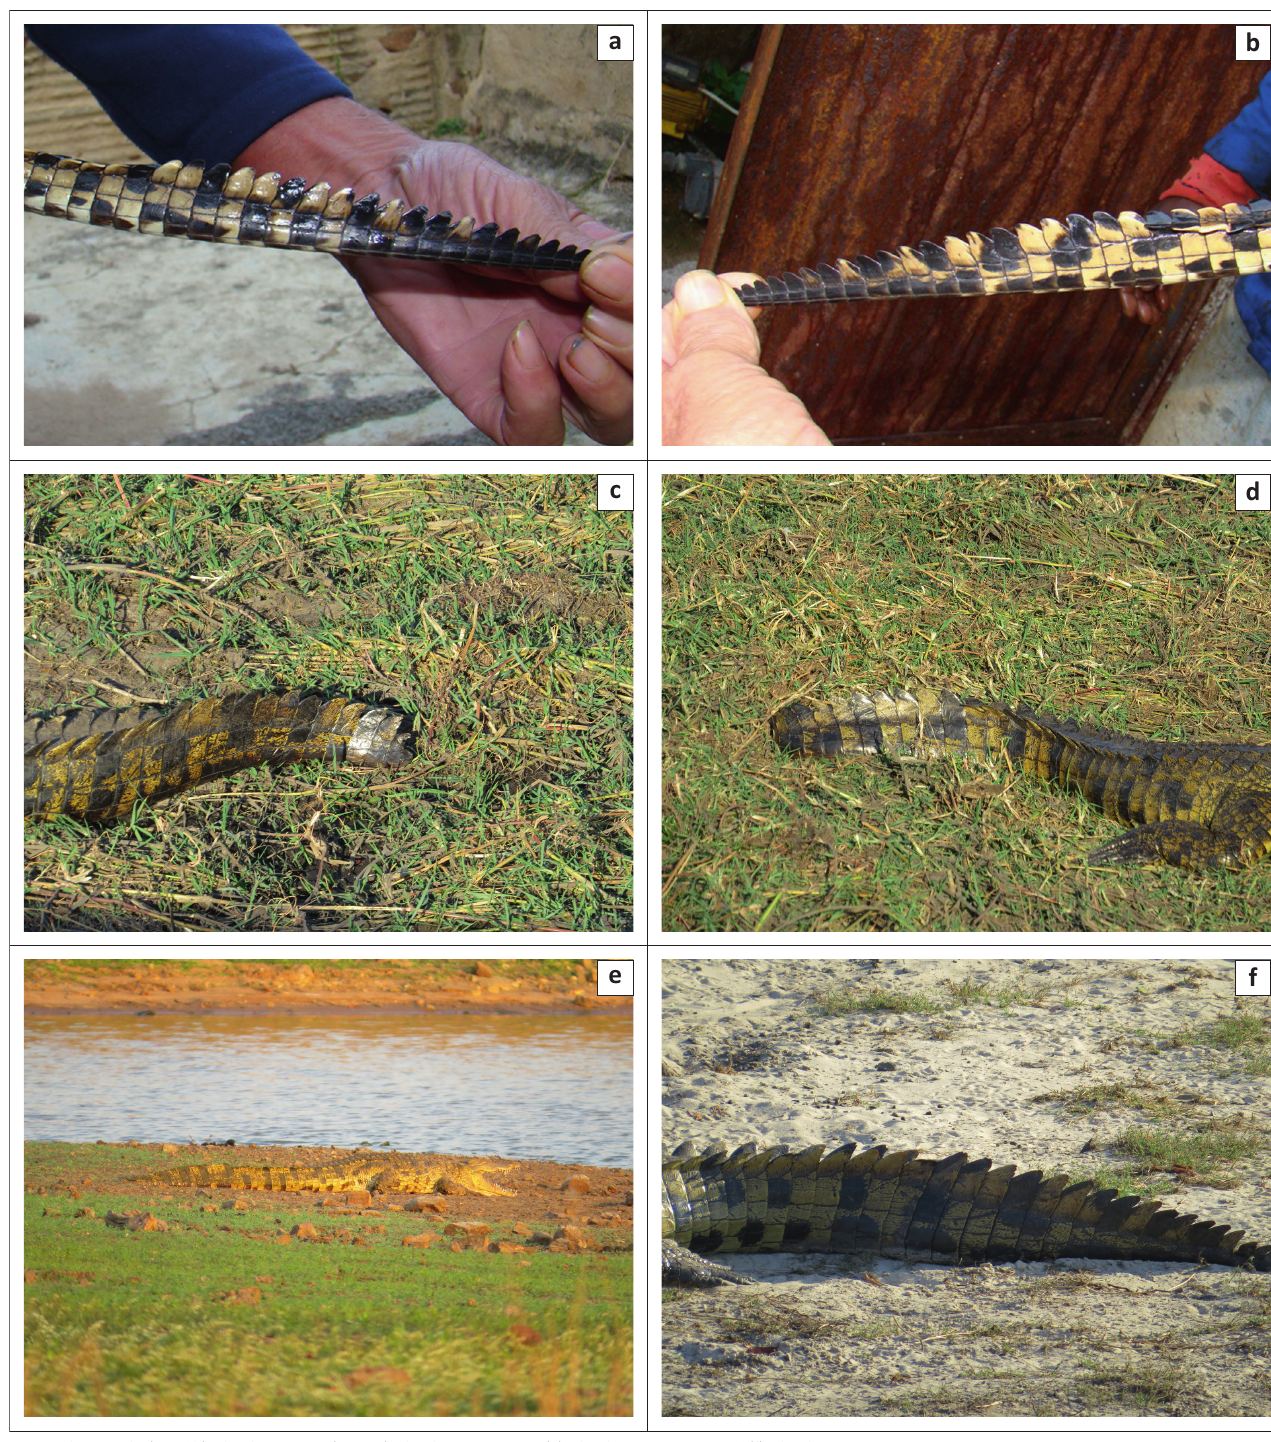
TABLE 1: Data of scores per age group from the Castlekop Crocodile Farm. Age Number crocodiles Light or white < 50 % Dark > 50 % Dark Dark or black Missing